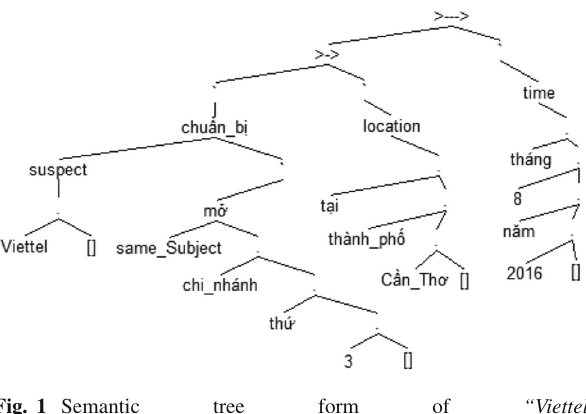
Fig. 1 Semantic tree form of